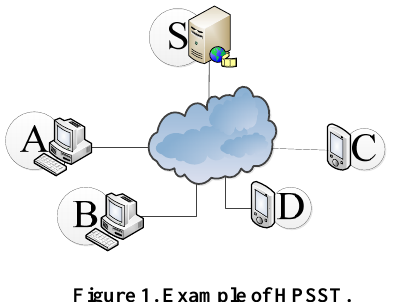
Figure 1. Example of HPSST.